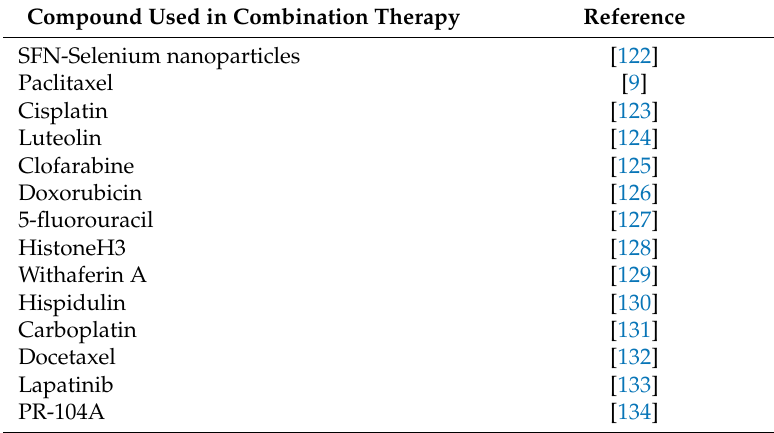
Table 4. CombinationTherapiesofSulphoraphaneandConventionalAnti-CancerandAntibacterialDrugs.